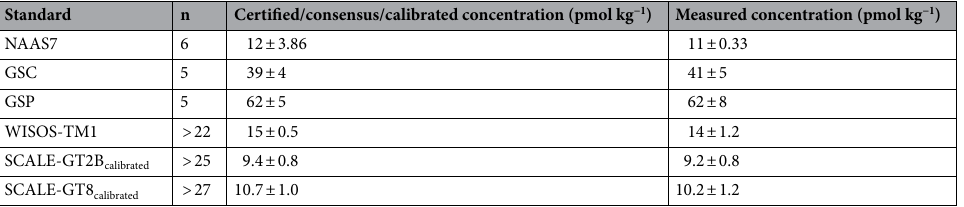
Table 1. The results of the accuracy tests.